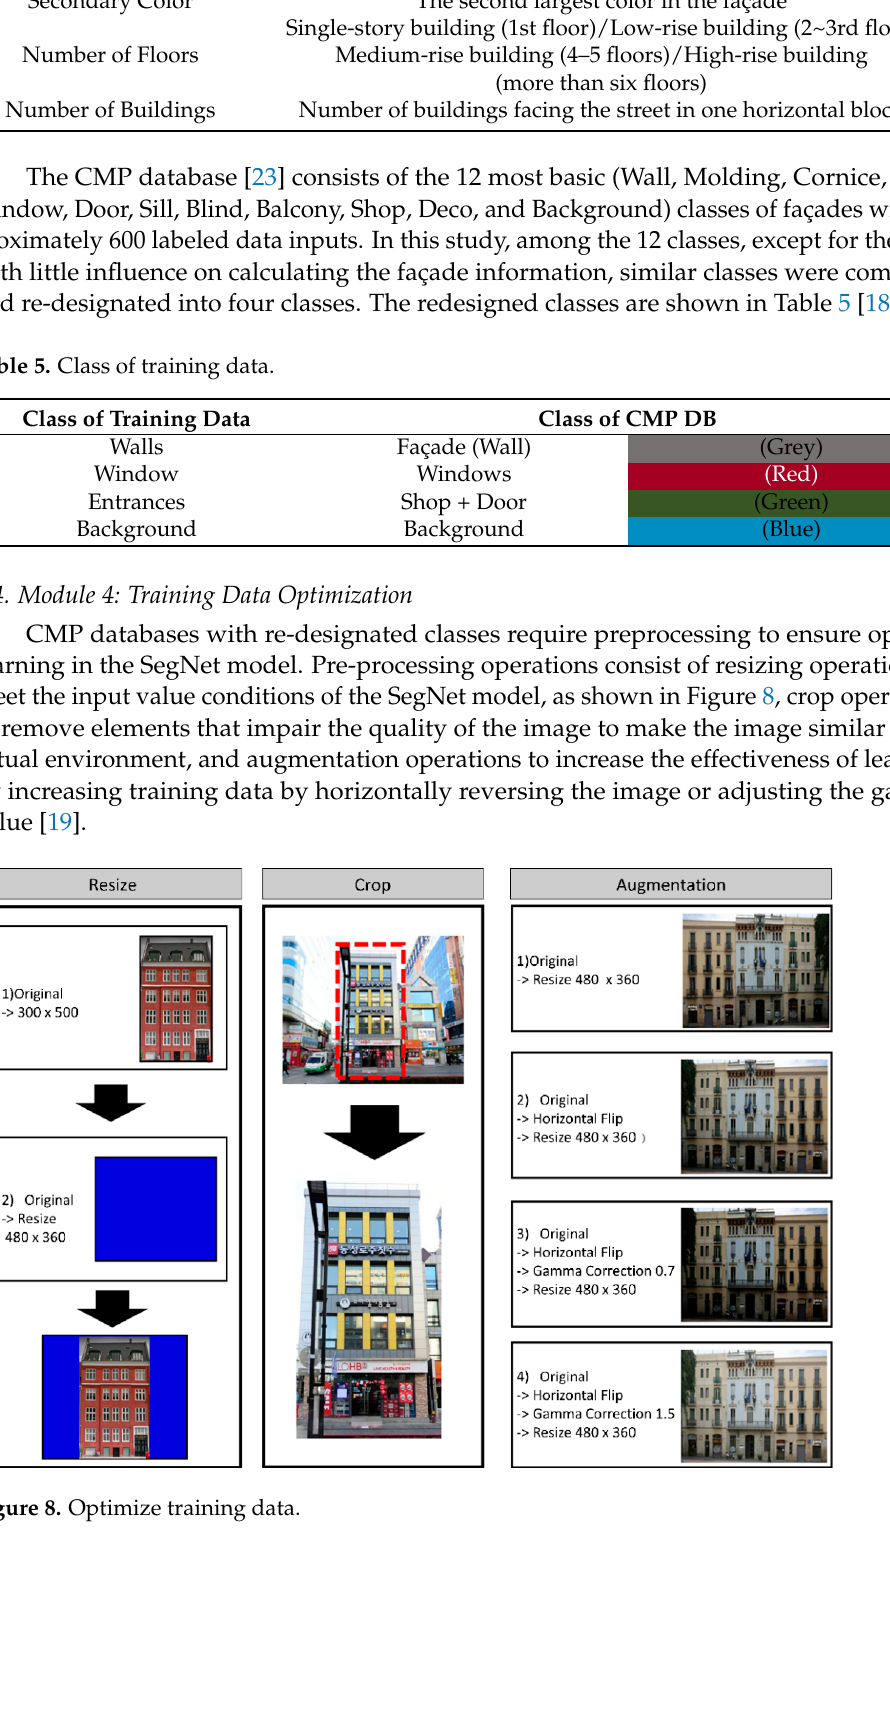
Table 4. The Definition of façade information.